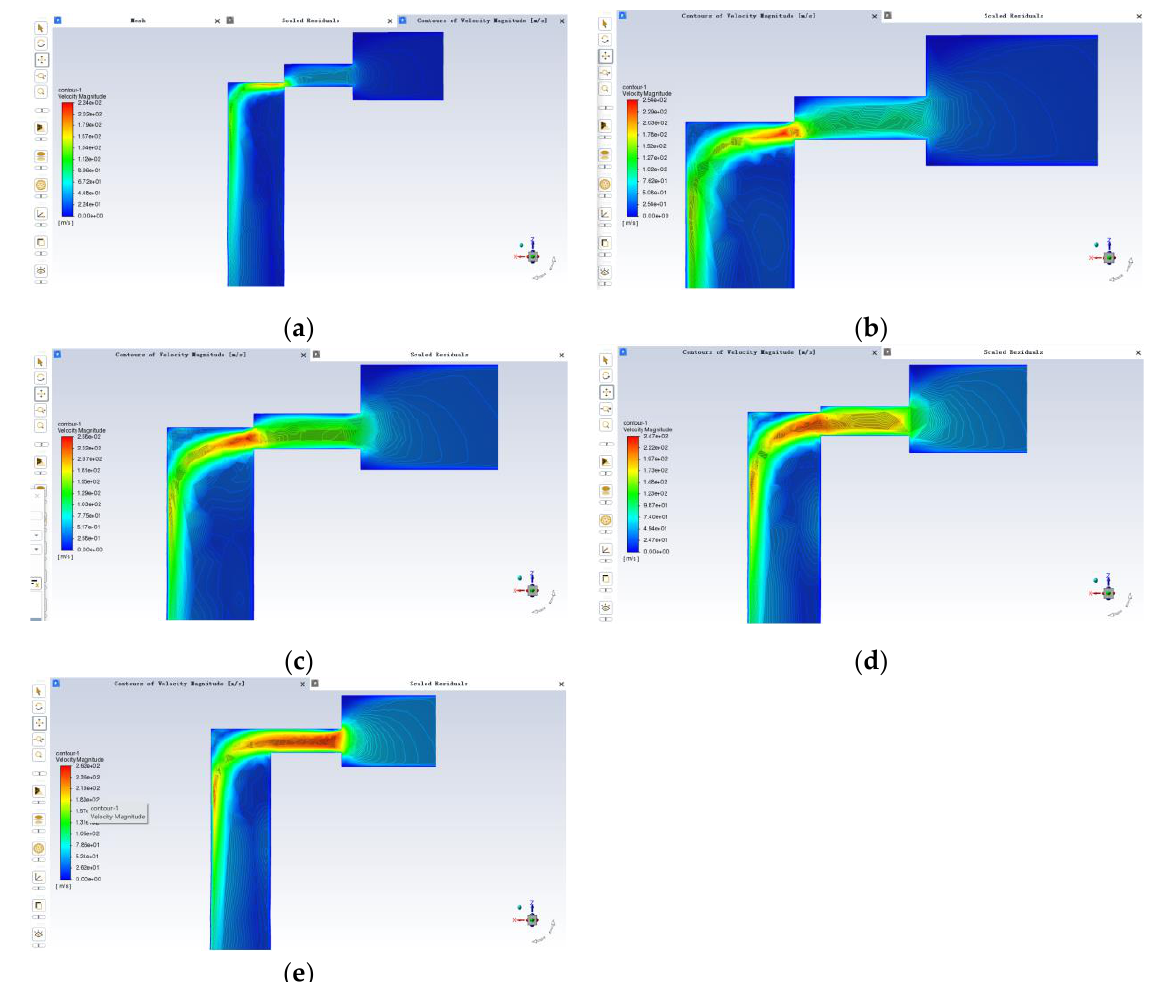
Figure 6. Valve port flow velocity analysis: ( a ) 0.1 mm; ( b ) 0.2 mm; ( c ) 0.3 mm; ( d ) 0.4 mm; ( e ) 0.5 mm.